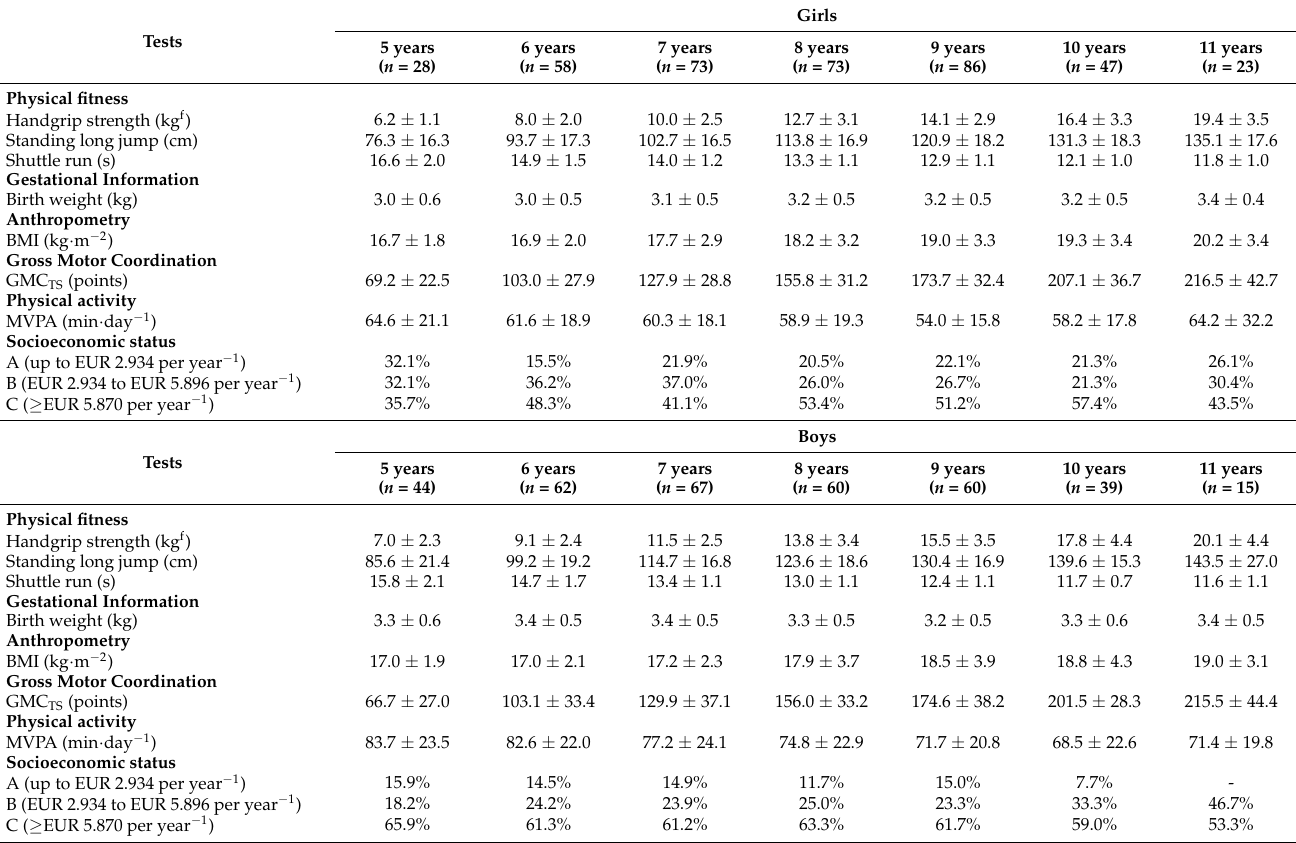
Table 2. Descriptive statistics (mean ± SD or percentage) for girls ( n = 177) and boys ( n = 171) from 5 to 11